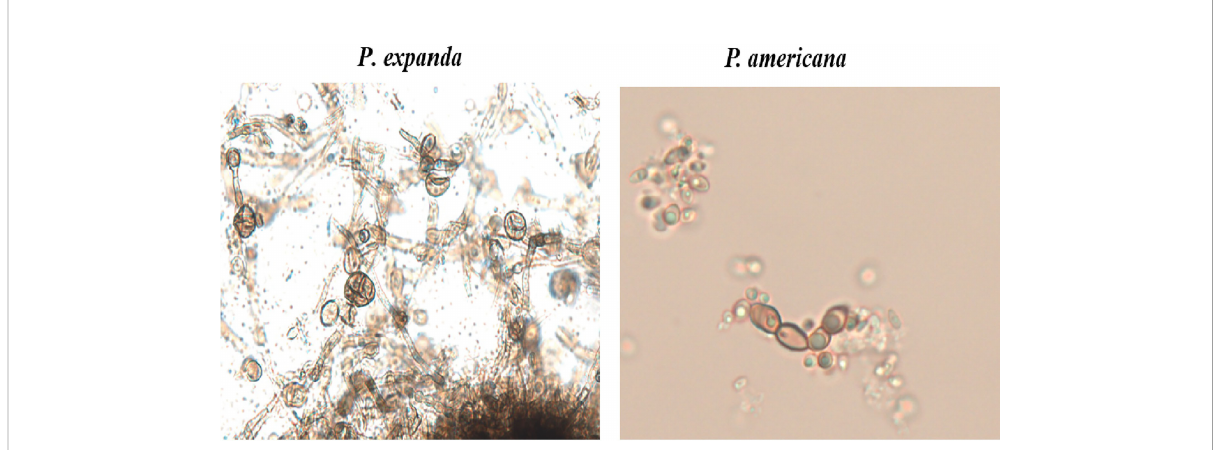
FIGURE 6 In vitro induction of muriform cells. Induction experiments in vitro to induce muriform cells (original magni fi cation ×400). After 50 days P. expanda was easier to form muriform cells, but P. americana was beaded